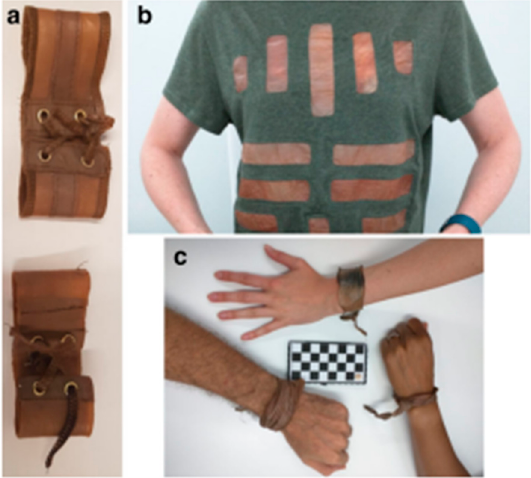
Figure 14. Photographs of the finished articles of clothing: ( a ) wristband, ( b ) t-shirt with sewn in cellulose-based coated fabric, and ( c ) wristband after 2 weeks of use. Reprinted with permission from [168]. Copyright 2020 Springer Nature.